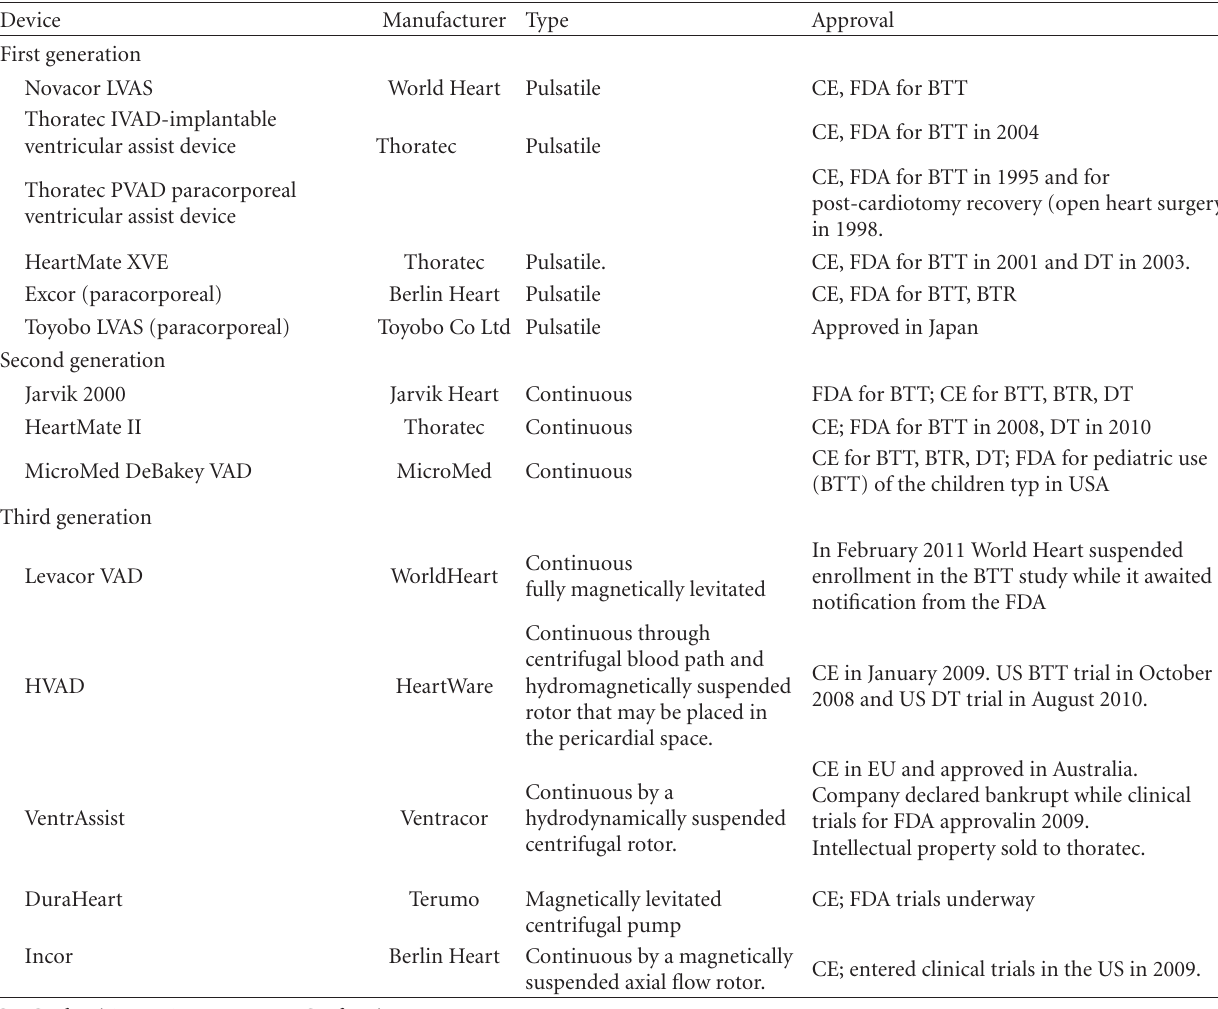
Table 1: Left ventricular assist devices currently in